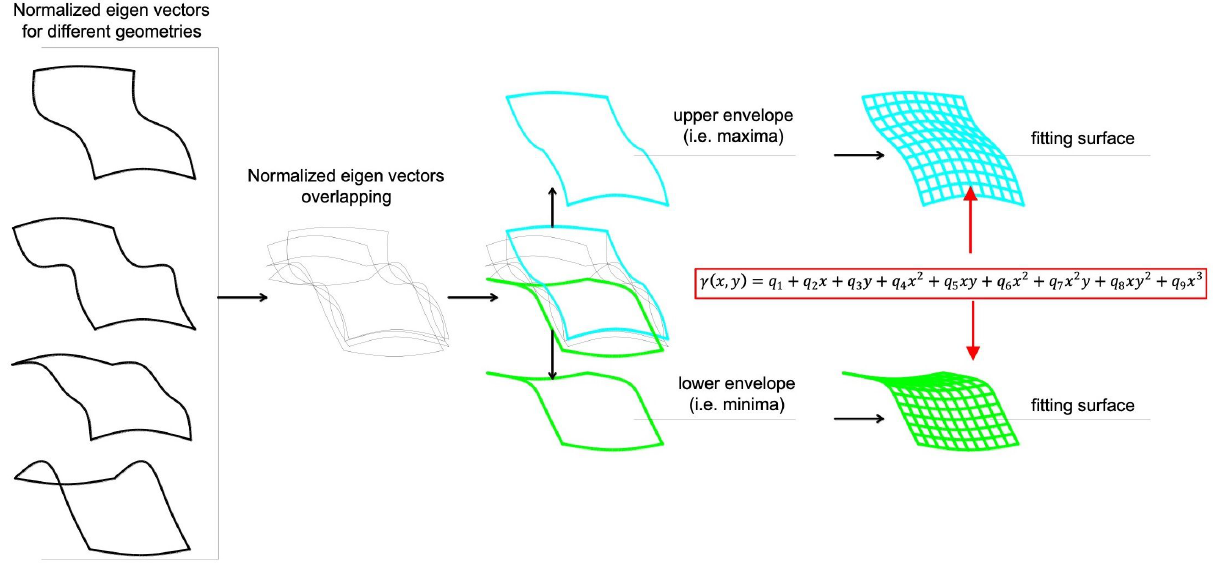
Figure 12: Example of envelope of the maxima and minima Normalized eigenvectors for θ = 0 ∘ , pressure mode